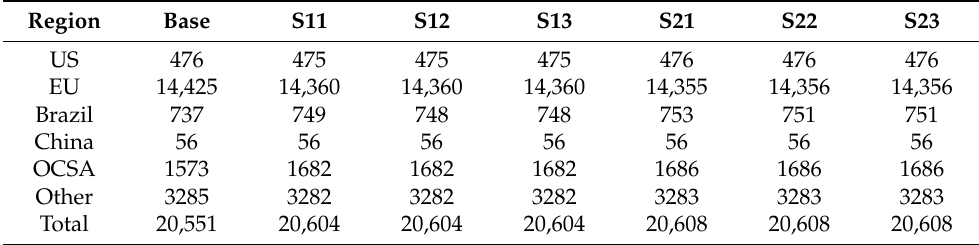
Table 4. EU imports of beef by exporting region for all examined scenarios (in million USD).